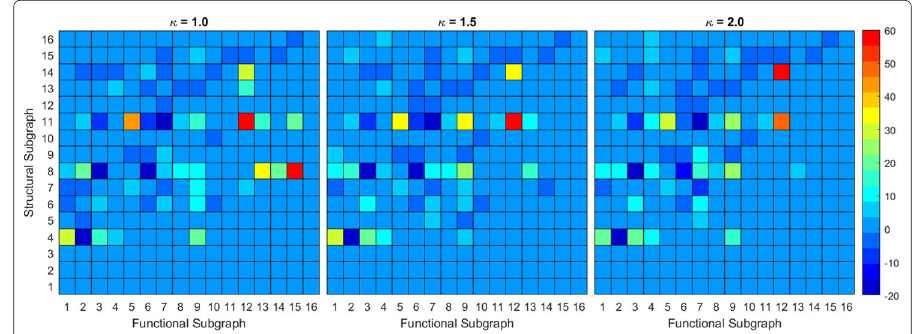
Fig. 11 Triadic Z -scores for TE reconstruction of the 1024 neuron network. Heatmap of the Z -scores of the larger network using transfer entropy for functional reconstruction. The anti-diagonal consists of preservation transformations while off anti-diagonal are conversion transformations. The lower right triangle consists primarily of FP transformations while the upper left triangle consists primarily of FN